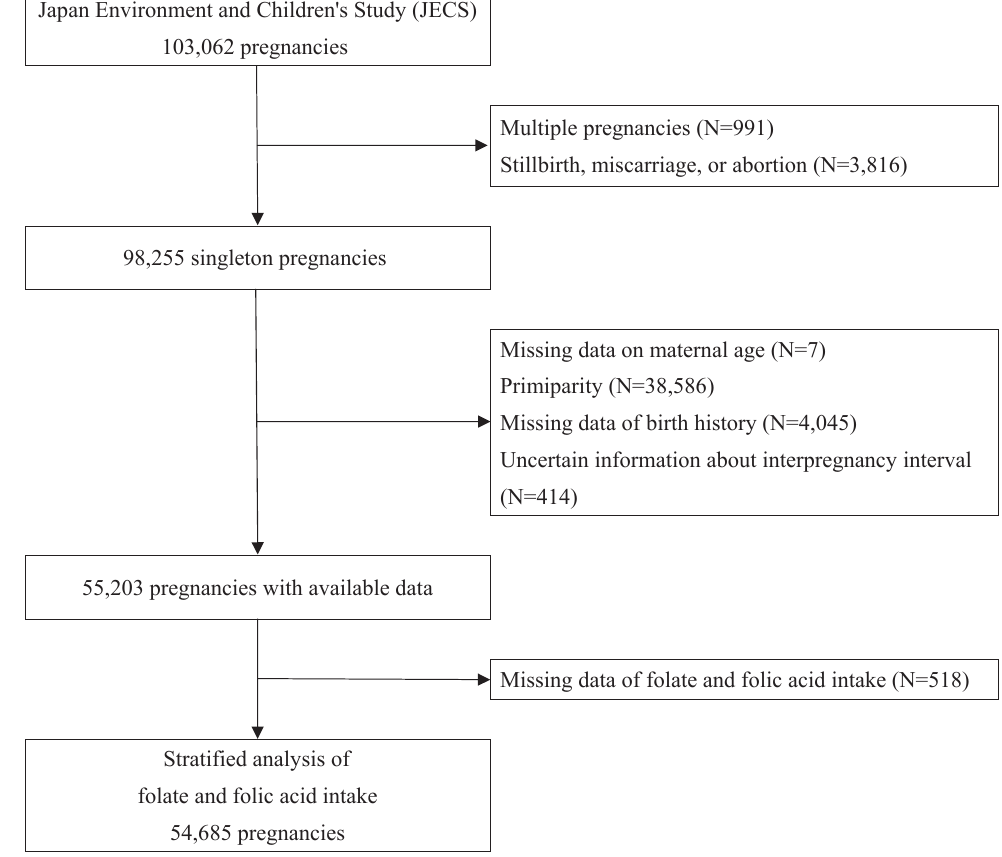
Figure 1. Flow chart of participant